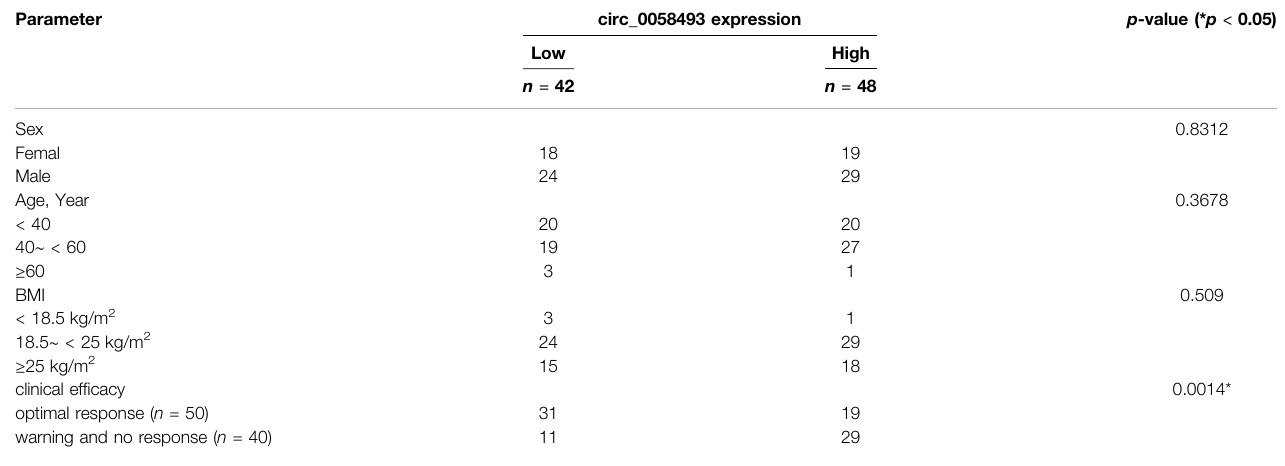
TABLE 1 | Relationship between hsa_circ_0058493 expression and clinicopathologic factors of patients with CML.